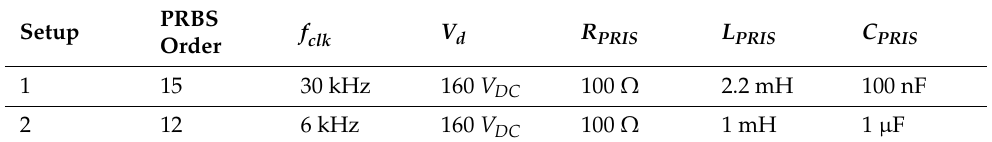
Table 8. Parameters for two different arrangements of the PRIS source, setup 1 and setup 2.